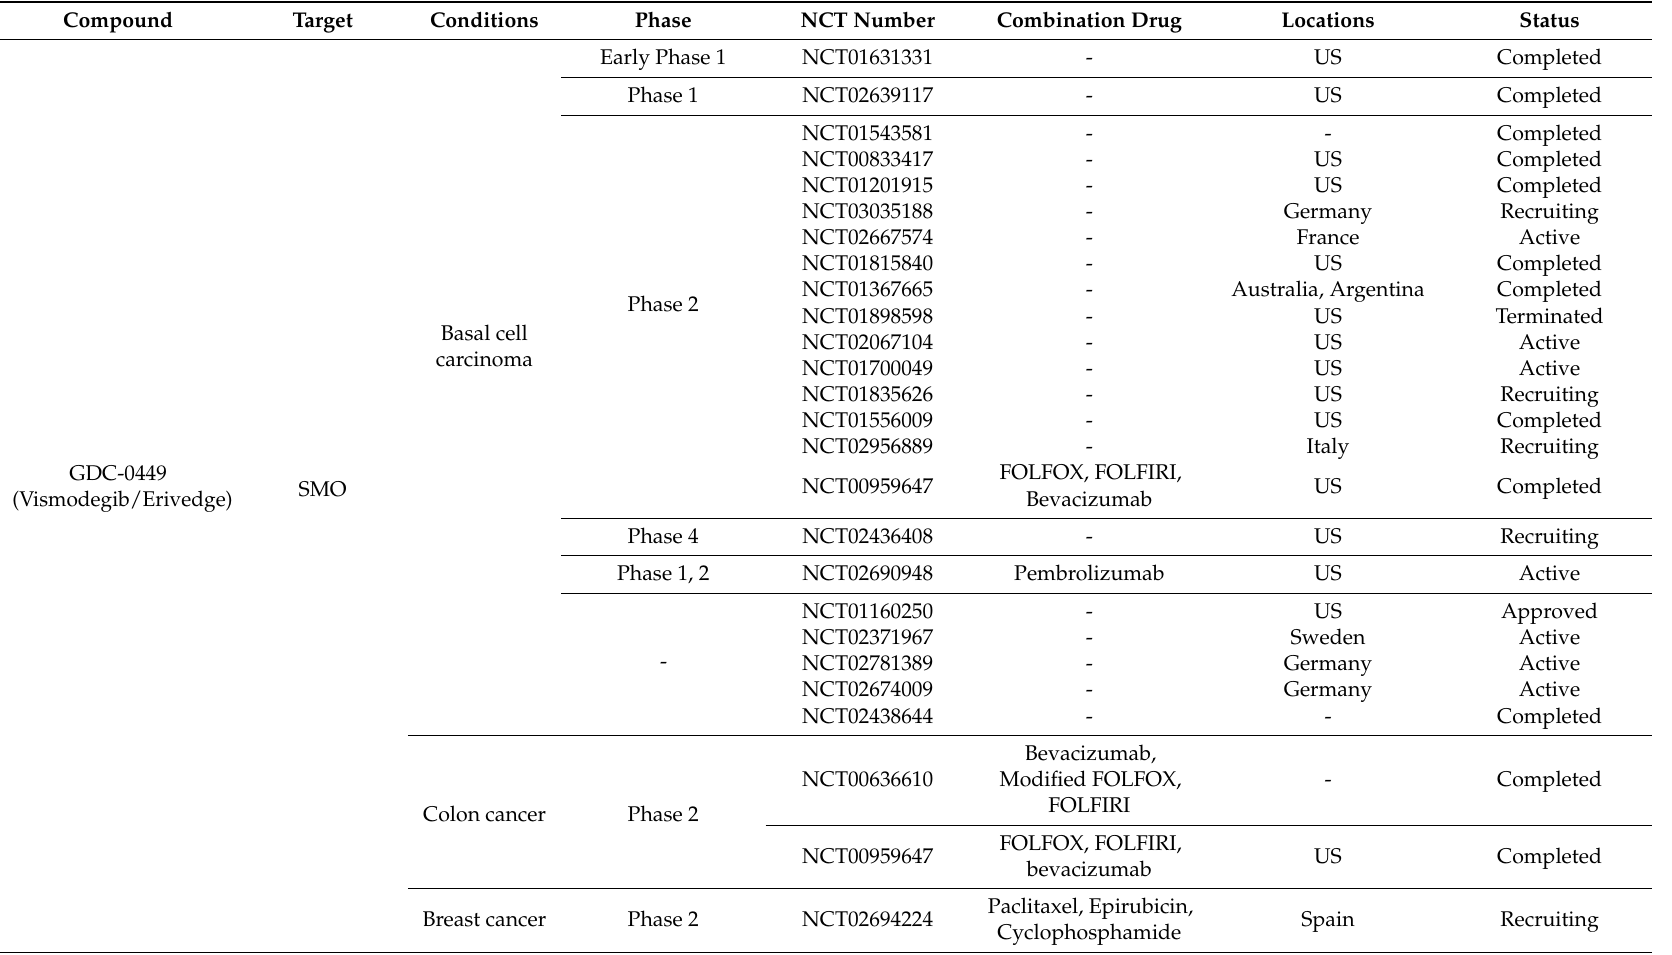
Table 3. Hedgehog signaling inhibitors in clinical trials. Data from